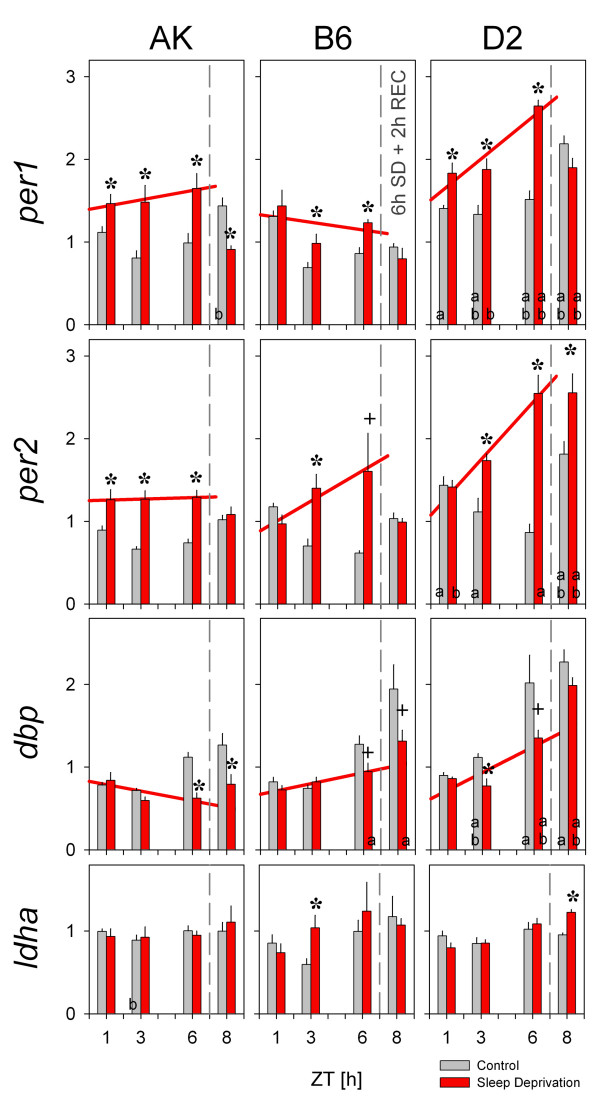
Mean (+1SEM) forebrain mRNA levels of per1, per2, dbp, and ldha (top to bottom panels) for AK (left), B6 (middle) and D2 (right panels) mice after sleep deprivations (SD) of 1-, 3-, and 6 h (red bars). All SDs started at light-onset (ZT0). Control animals (grey) were sacrificed along with the SD animals. Effects of recovery sleep on expression were assessed by allowing 2 h of recovery (REC) after 6 h SD (ZT8). per1, per2, and dbp, but not ldha expression, was affected by SD, genotype, and time-of-day (3-way ANOVA factors 'SD' and 'genotype': P < 0.0001, factor 'ZT': per1 P = 0.0002, per2 P = 0.004, dbp P < 0.0001). For both per genes the SD effect differed among genotypes ('SD'-'genotype' interaction: per1: P = 0.039; per2: P = 0.006). Linear regression lines (red) describe the time course of mRNA changes during SD (ZT1 through ZT6; see Fig.2). Asterisks and crosses mark times when SD differed from controls (P < 0.05 and P < 0.10, respectively; post-hoc t-tests). Symbols 'a' (> AK) and 'b' (> B6) mark strain differences for each time point and condition (P < 0.05; post-hoc Tukey).